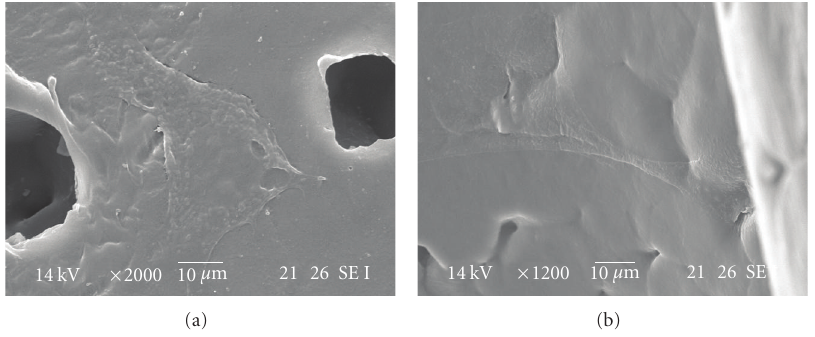
Figure 10: SEM micrographs of cells adhesion and spreading on the external and internal surface of the PCL sca ff